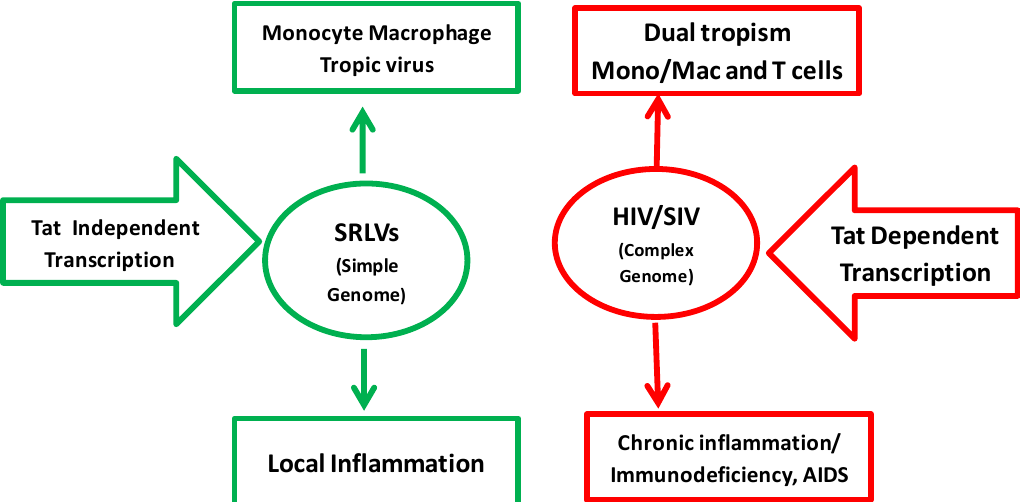
Figure 1. Comparison of SRLV and HIV-1 properties. SRLV replication is restricted to monocyte/macrophage cell lineage. HIV-1 can target both monocytes/macrophages and CD4+ T cells using CD4 as the main receptor and either CCR5 or CXCR4 as the co-receptor. The replication of HIV/SIV is highly dependent on Tat transactivation, while replication of SRLVs is fully independent and constitutive. The pathogenesis of SRLVs is characterized by local inflammatory diseases in target organs while HIV-1 induces